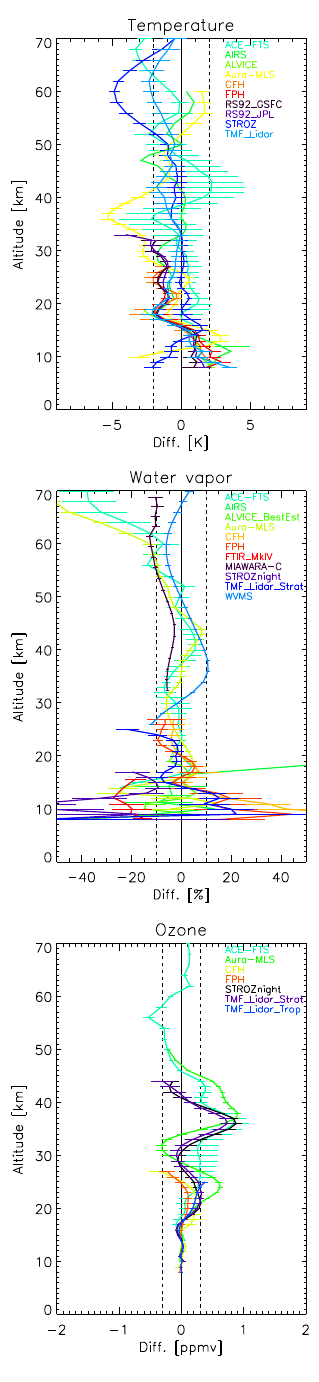
Fig. 19. Compilation of the mean differences between MIPAS and all instruments (MIPAS – correlative instrument) to which compar- isons have been performed. Top: all mean temperature differences and their standard errors; middle: all mean water vapor differences and their standard errors (in percent relative to the reference pro- file); bottom: all mean ozone differences and their standard errors. Vertical lines are meant as guide for the eyes only.